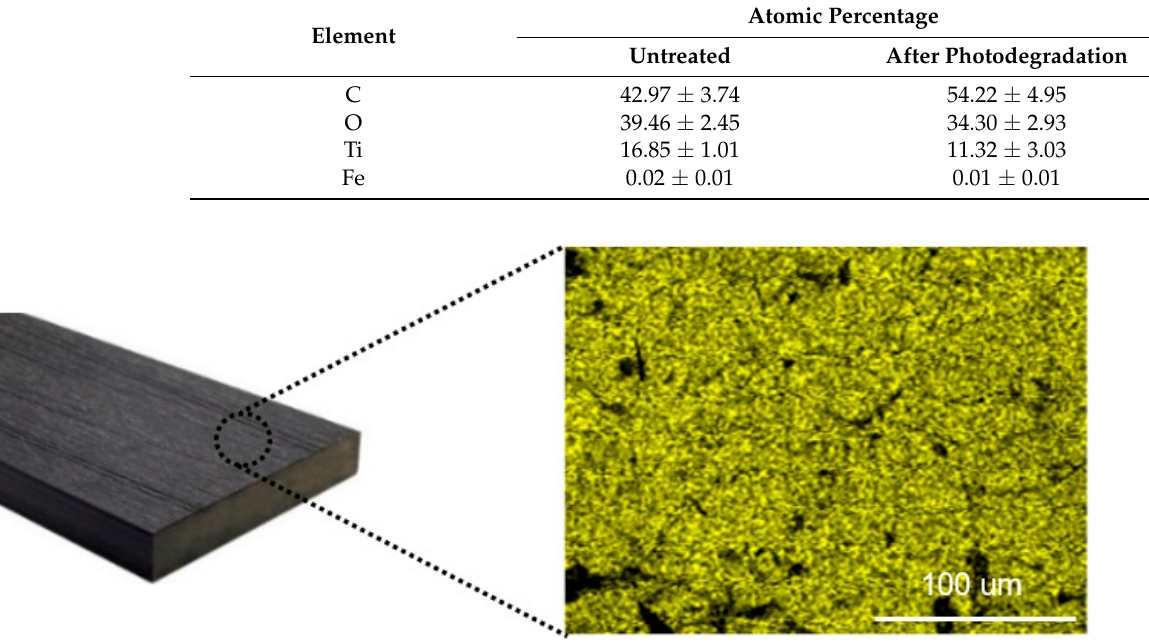
Figure 11. Elemental distribution images of Fe/TiO 2 –cMDF after photodegradation (Blue LED). 3.4.2. Photodegradation Performance of Fe/TiO 2 –cMDF under Commercial LED Bulbs After confirming the photocatalytic ability of Fe/TiO 2 –cMDF under Blue LED, pho- todegradation of MB was tested under two different commercial LED bulbs (8 W, 12